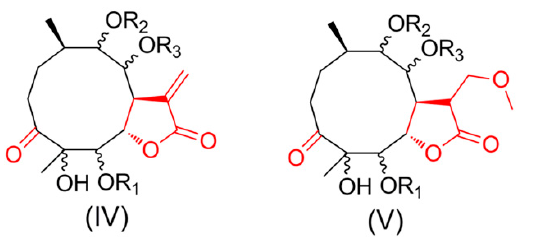
Figure 1. Subtypes IV and V of germacranolides. The basic structure of cardivarolides is same as subtypes IV.